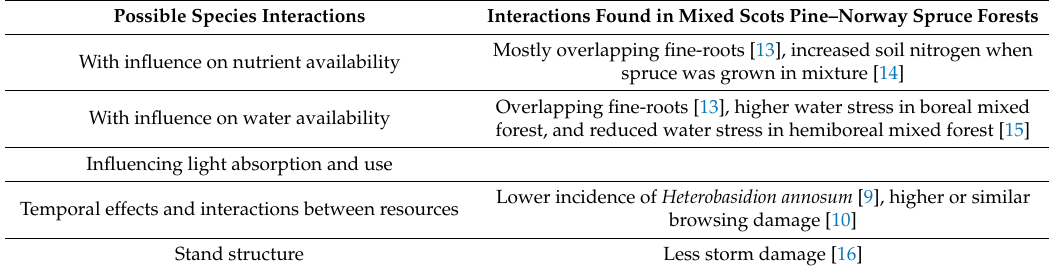
Table 1. Possible tree species interactions in mixture according to Forrester [12], and evidence for such interactions from investigations in Scots pine-Norway spruce